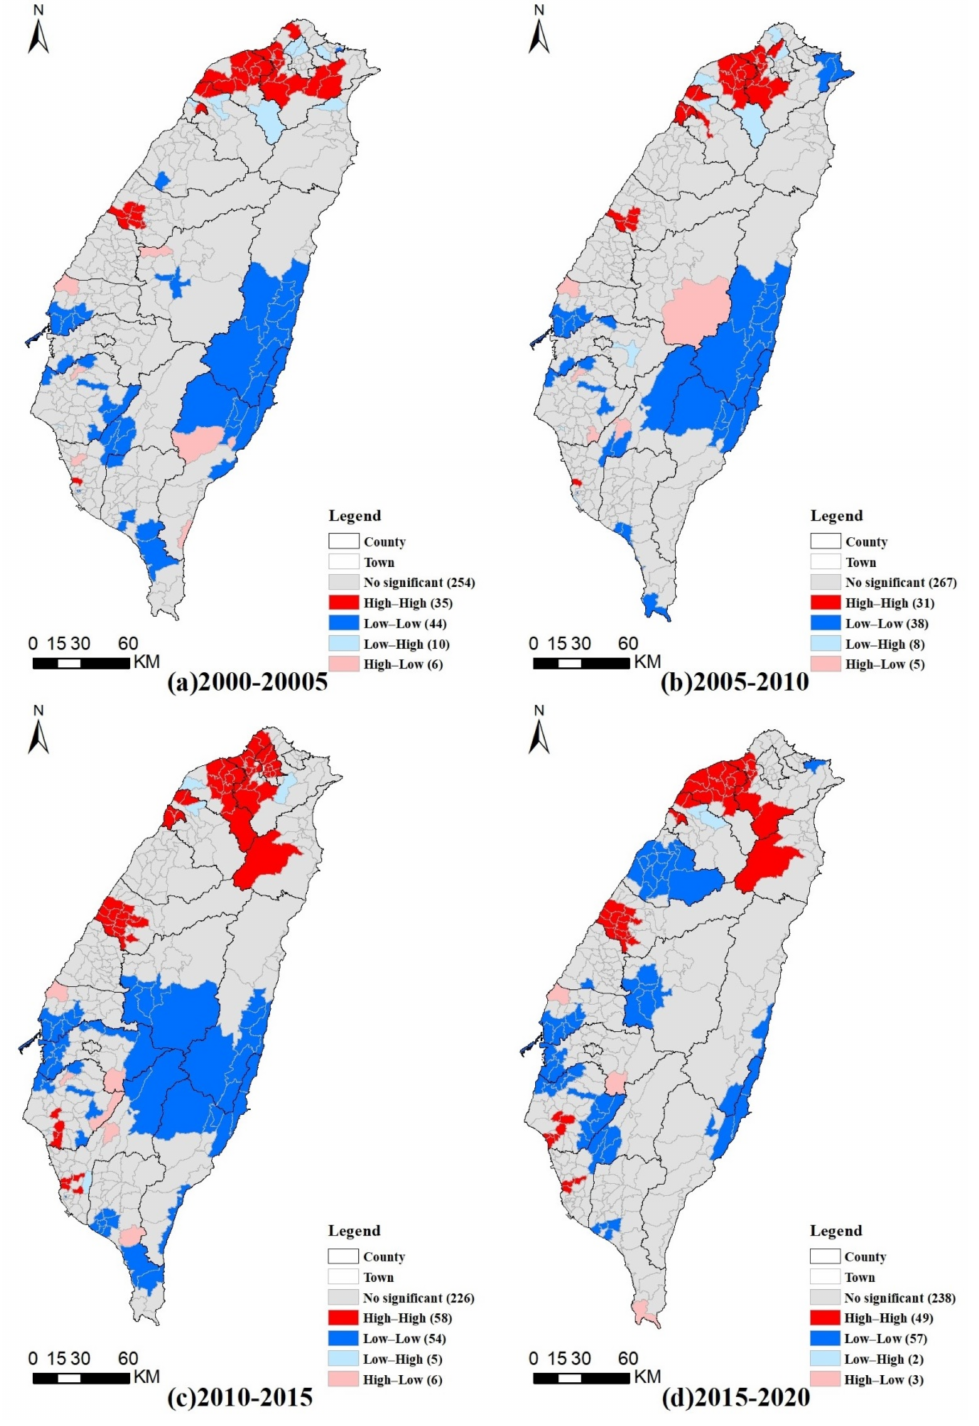
Figure 8. LISA cluster map of the change in each town’s registered population. The “low–high” clusters appeared mainly around the Taipei Metropolitan Area, Taoyuan City, Hsinchu County, and Hsinchu City. Taipei City is the political and eco- nomic center of Taiwan. Taiwan’s gateway airport is located in Taoyuan City. Hsinchu Science Park, considered the most valuable industrial area in Taiwan, is located